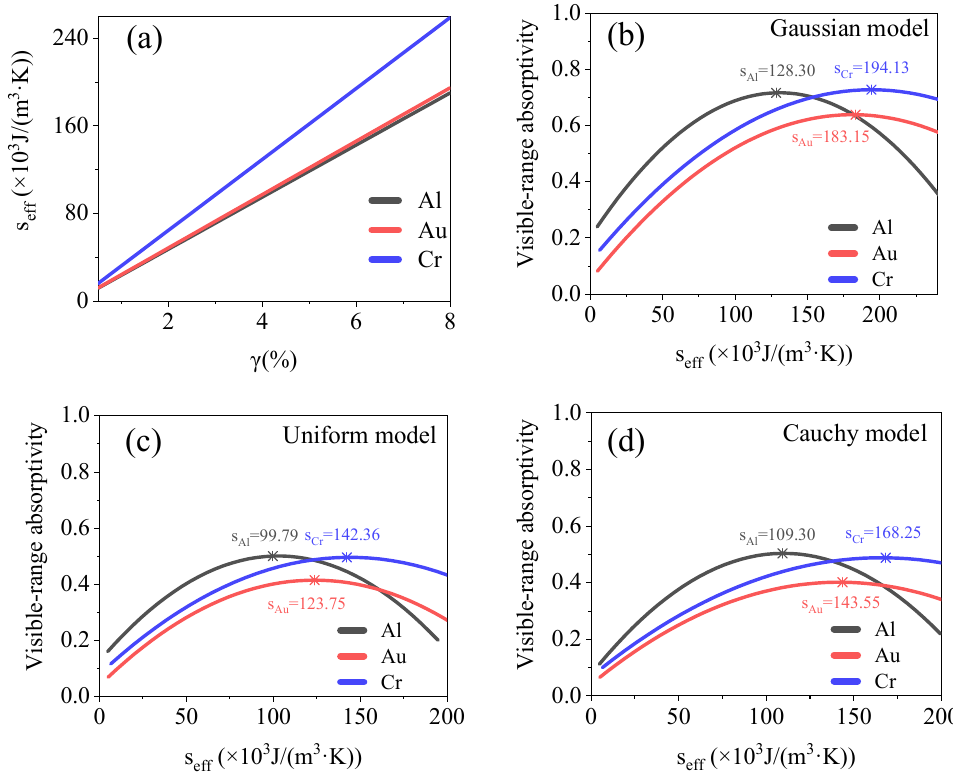
Figure 9. ( a ) Relationship between filling factor and equivalent volumetric heat capacity of model. ( b – d ) Relationship between equivalent volumetric heat capacity and visible-range absorptivity of Gaussian, uniform, and Cauchy models. Equivalent volumetric heat capacity of model with maximum absorptivity is marked in the figures.